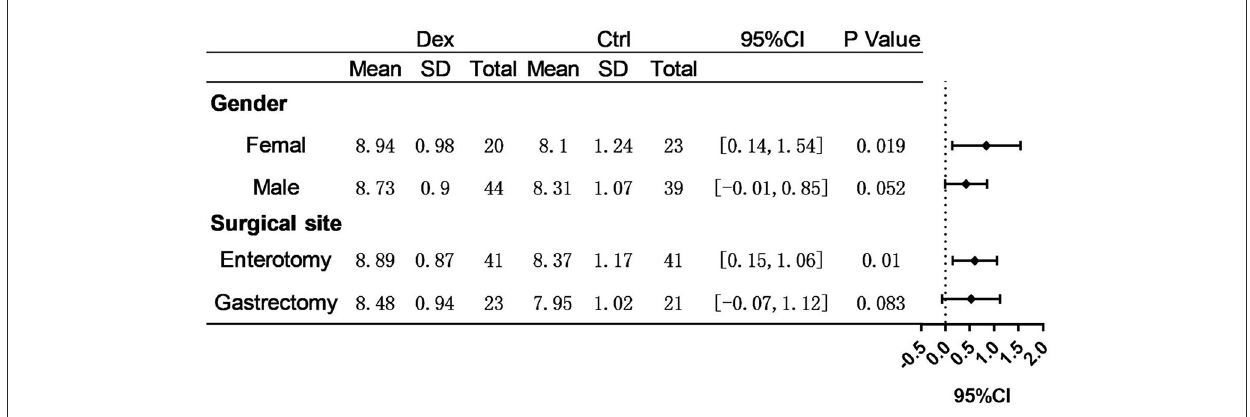
FIGURE3 Assessment of differences in avervage daily enteral nutrition caloric intake. P -value represent intra-group